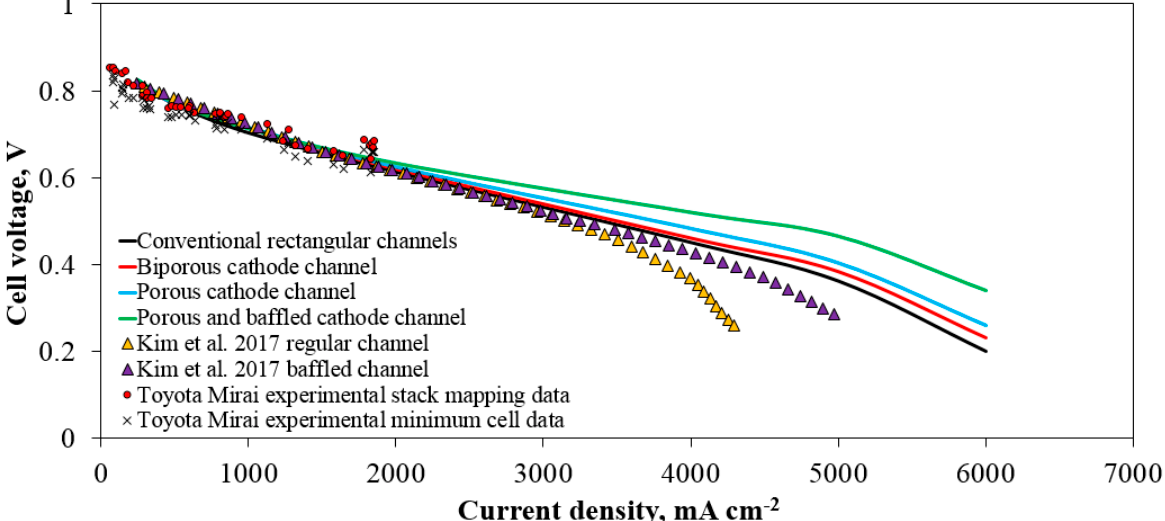
Figure 2. Polarization curve comparison for different configurations.